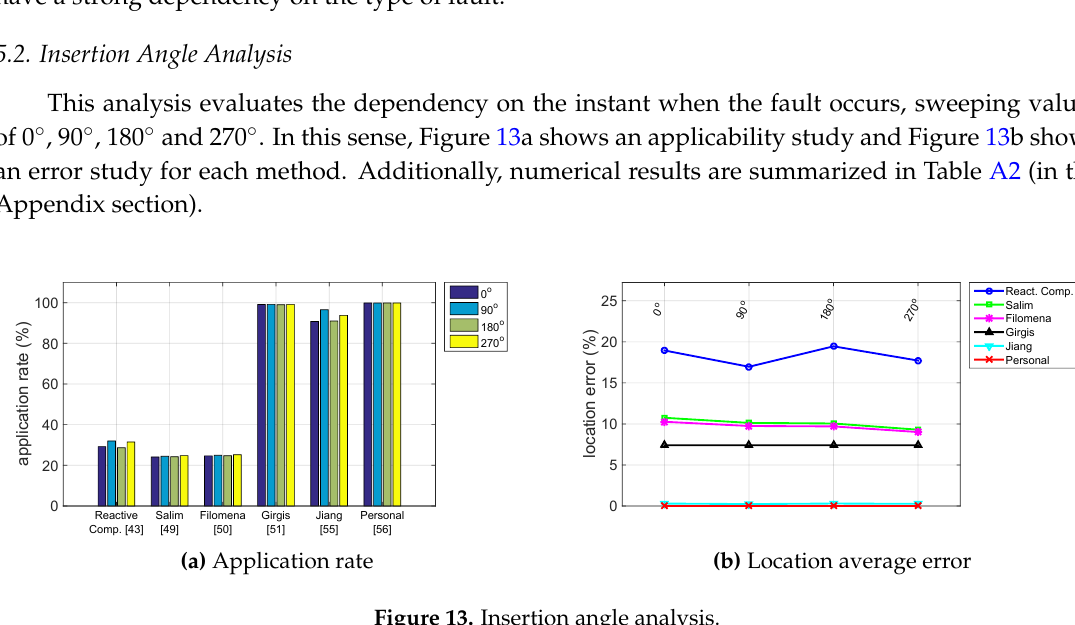
Figure 13. Insertion angle